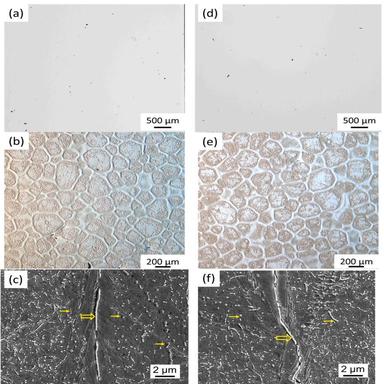
Low magnification microstructure of 85% (a-c) and 105% (d-f) binder saturation samples. (a) and (d) represent the unetched optical micrographs indicating porosity distribution in the as-sintered state, (b) and (e) represent the etched optical micrographs in the as-sintered state, and (c) and (f) represent secondary electron images in the assintered state. Cuboidal carbides within the matrix are represented by solid yellow arrows, and grain boundary eutectic carbides are represented by hollow yellow arrows.